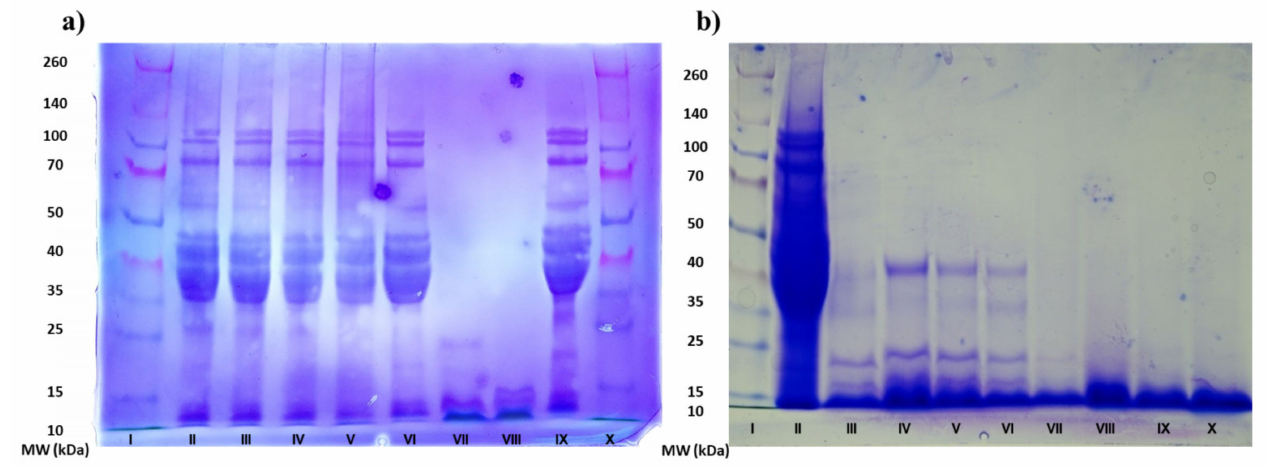
Figure 7. SDS-PAGE profiles of Gluten, MWT gluten at different microwave power (200–800 W), CGH and MWGH. ( a ) Band: I—protein standard, II—MWT 200 W, III—MWT 400 W, IV—MWT 600 W, V—MWT 800 W, VI—Gluten, VII— CHG, VIII—MWGH, IX—Gluten, X—protein standard; ( b ) Band: I—protein standard, II—Gluten, III—CGH, IV—CGH (at 45 min), V—CGH (at 90 min), VI—CGH (at 135 min), VII—MWGH, VIII—MWGH (at 45 min), IX—MWGH (at 90 min), X—MWGH (at 135